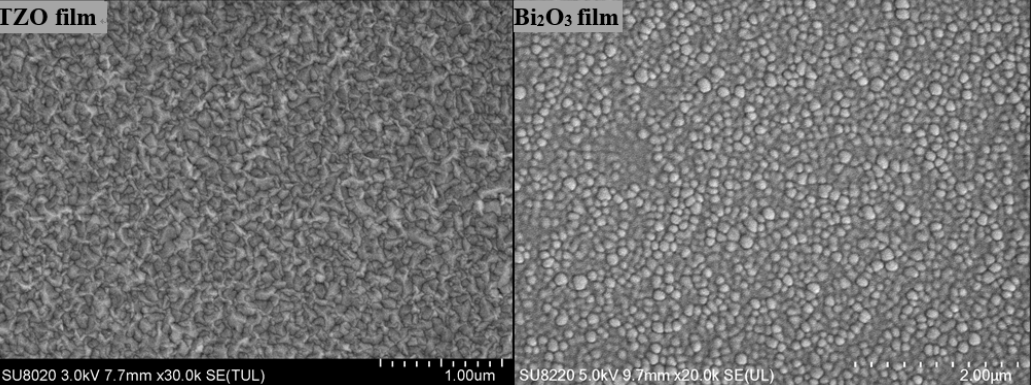
Figure 2. SEM micrographs of TZO and Bi 2 O 3 films.